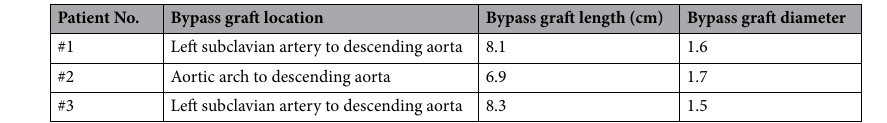
Table 2. Geometrical specifications of bypass grafts in patients 1, 2 and